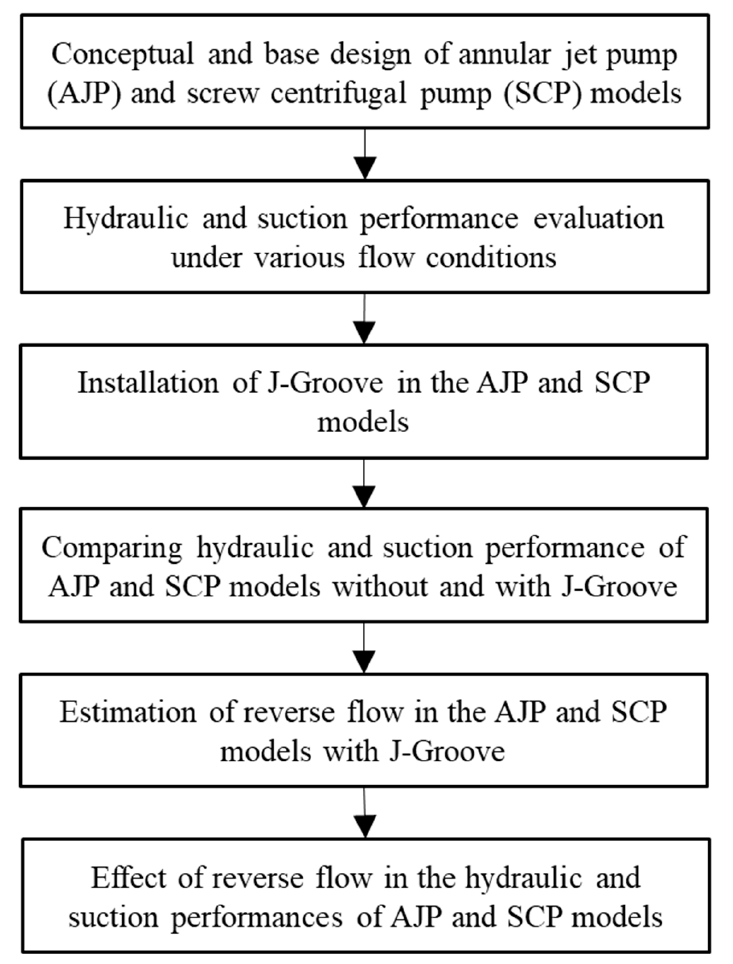
Figure 1. Workflow process for the estimation of reverse flow in AJP and SCP models with J-Groove.